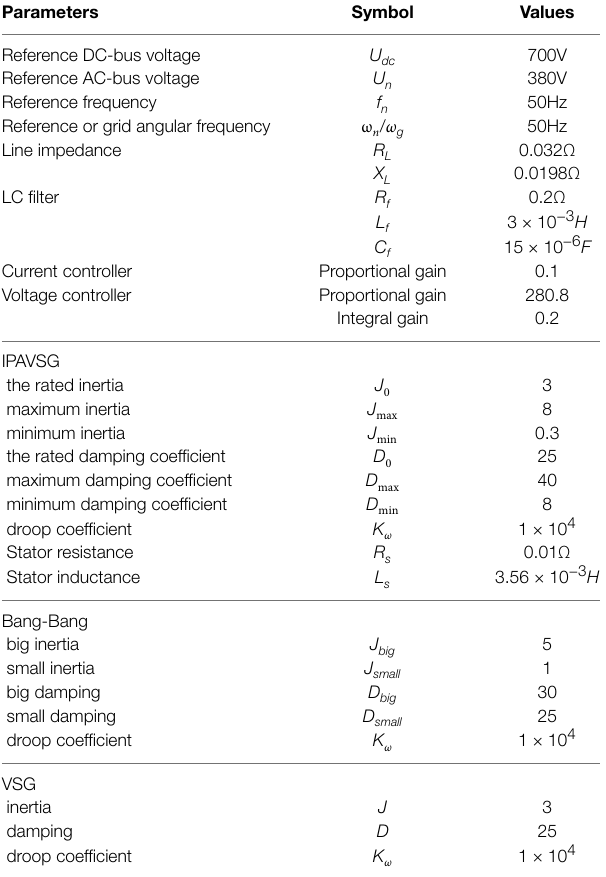
TABLE 3 | Parameters of the TEST system.